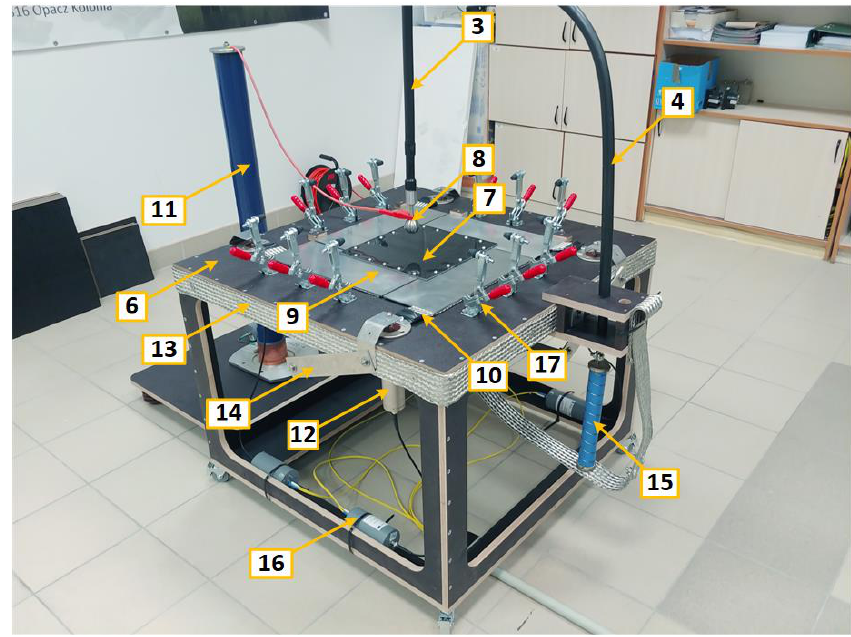
Figure 2. The view of the test bench with attached specimen: 3 — high-voltage cable, 4 — return path, 6 — test bench, 7 — laminate sample, 8 — high voltage electrode, 9 — ground return electrode, 10 — braided copper tape, 11 — high-voltage divider, 12 — current shunt, 13, 14 — return connection com- ponents, 15 — pulse forming part, 16 — fiber optic measuring system, 17 — specimen holding clamp.